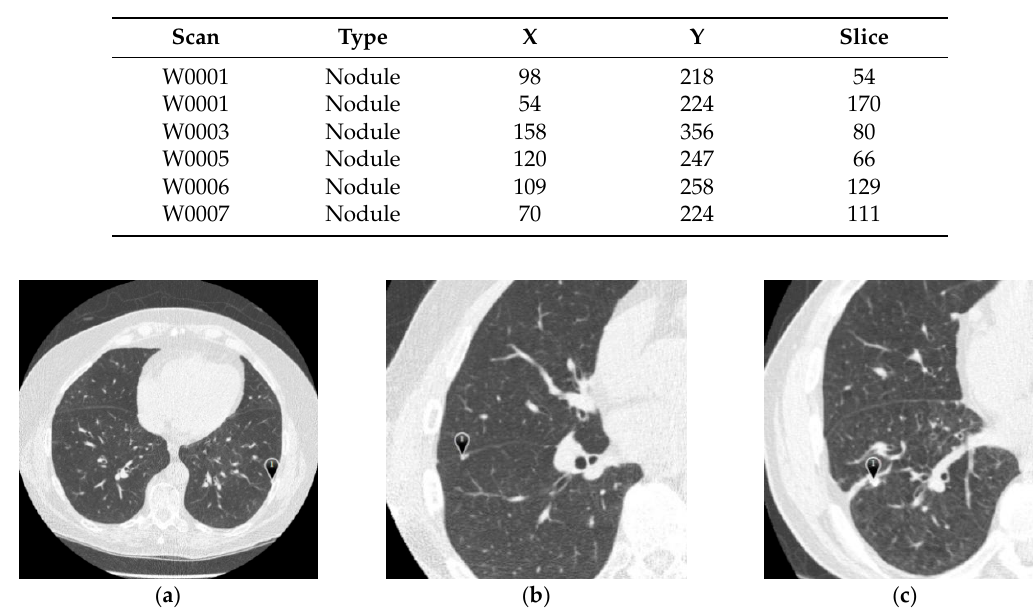
Table 2. Format of lung nodule position.